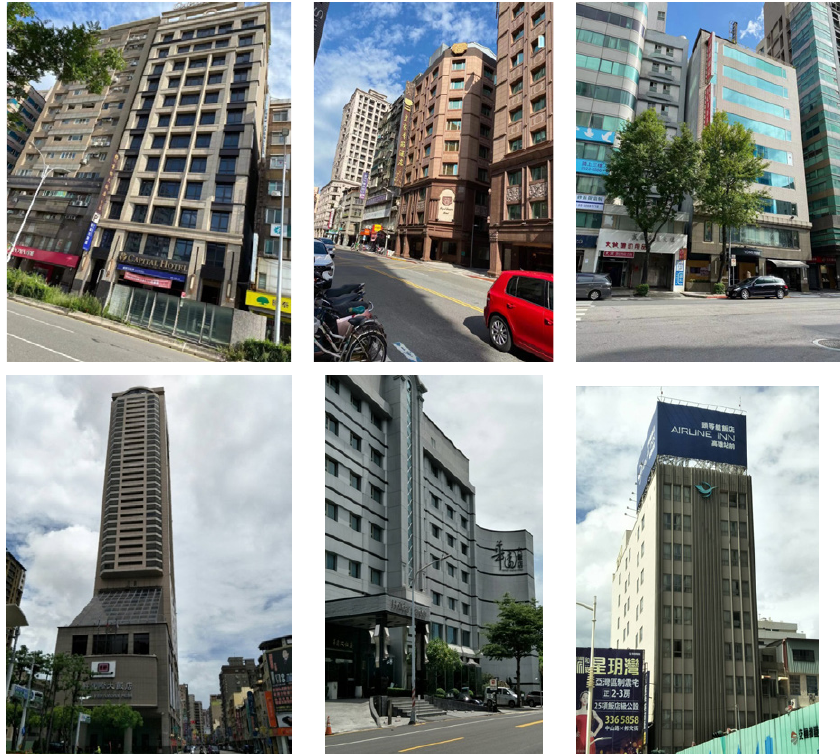
Figure 1. Some tourist hotels in Taiwan disclosed online for sale by real estate agents (photos by